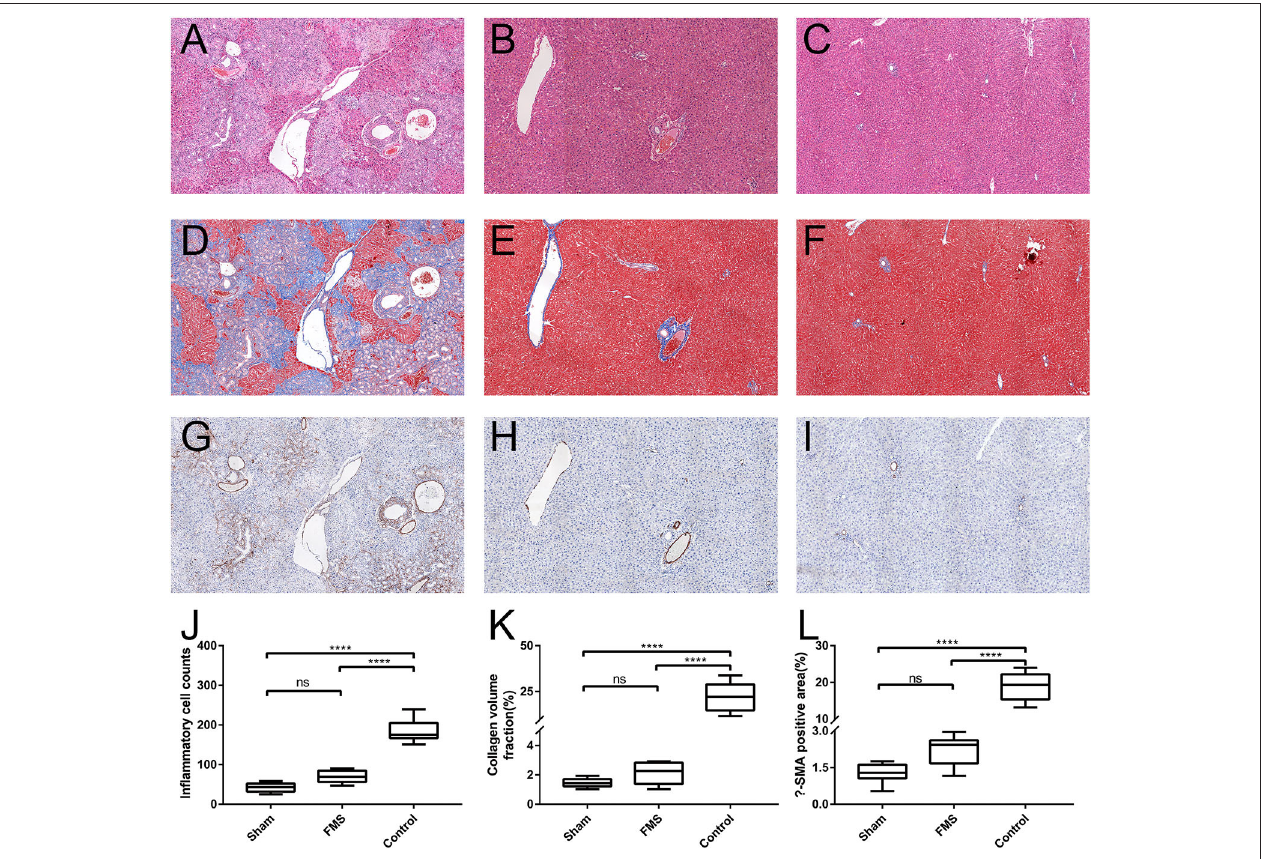
FIGURE 4 | The FMS reconstruction relieves the incidence of liver injury in vivo . The sections of liver tissue were stained with H&E. [ (A) control group. (B) FMS group. (C) sham group], Masson [ (D) control group. (E) FMS group. (F) sham group] and α -smooth muscle actin ( α -SMA) antibody [ (G) control group. (H) FMS group. (I) sham group]. The interstitial inflammatory cells were calculated in each group and measured (J) . There were lots of inflammatory cell infiltrations in the control group, but insignificant differences between the FMS group and sham group. Collagen volume fraction (CVF) was evaluated using Image Pro-Plus 6.0, there was no statistically significant difference in the FMS group and control group (K) . The α -SMA positive area in the three groups was also evaluated, similar results were seen with CVF (L) . **** P <